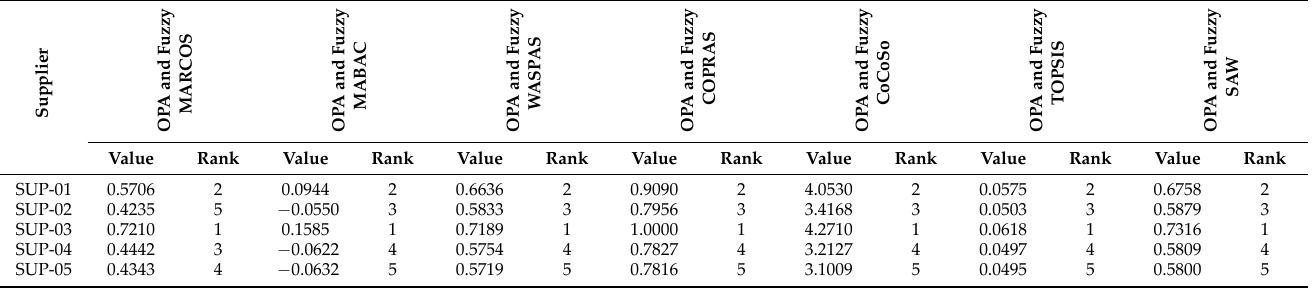
Table 12. Results of the comparative analysis of MCDM methods.